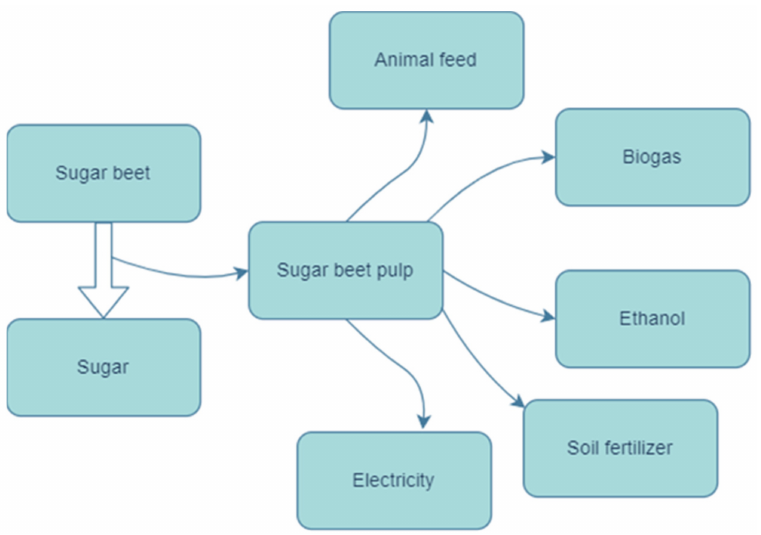
Figure 1. Potential uses of sugar beet pulp waste biomass by biorefinery conglomerates